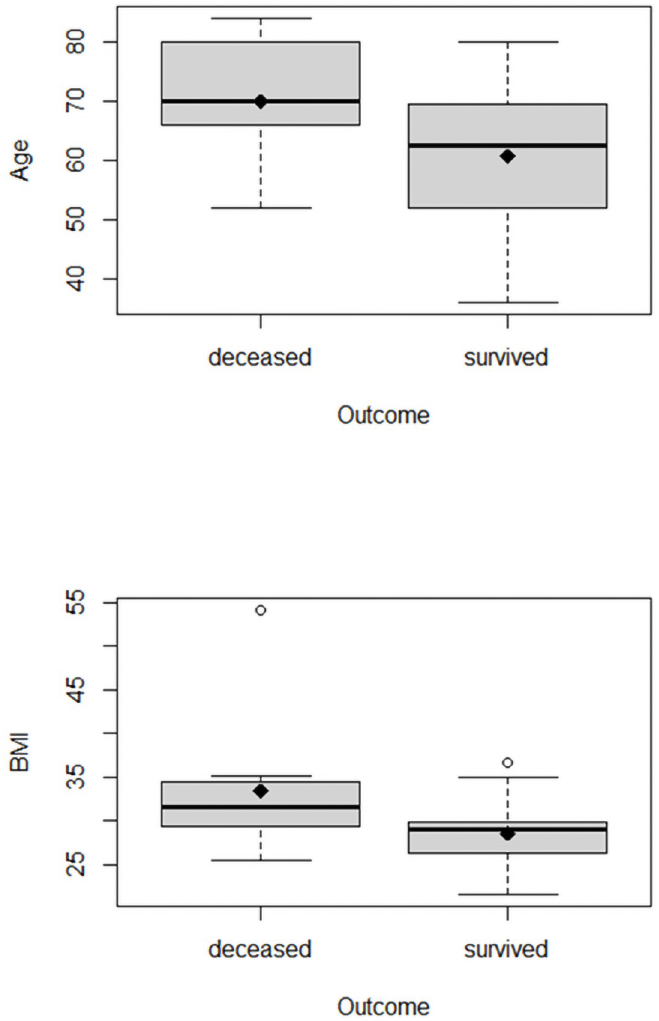
Fig 1. a, b: Association between age and BMI and COVID-19 mortality. Data are presented as arithmetic mean and media. The mean in survivors was 60 years, and the mean in deceased was almost 70 years. b, Association between BMI and COVID-19 mortality (p = 0.13). The mean in survivors was 28.5 kg/m2, and the mean in deceased was 33.4 kg/qm, which was not significant.